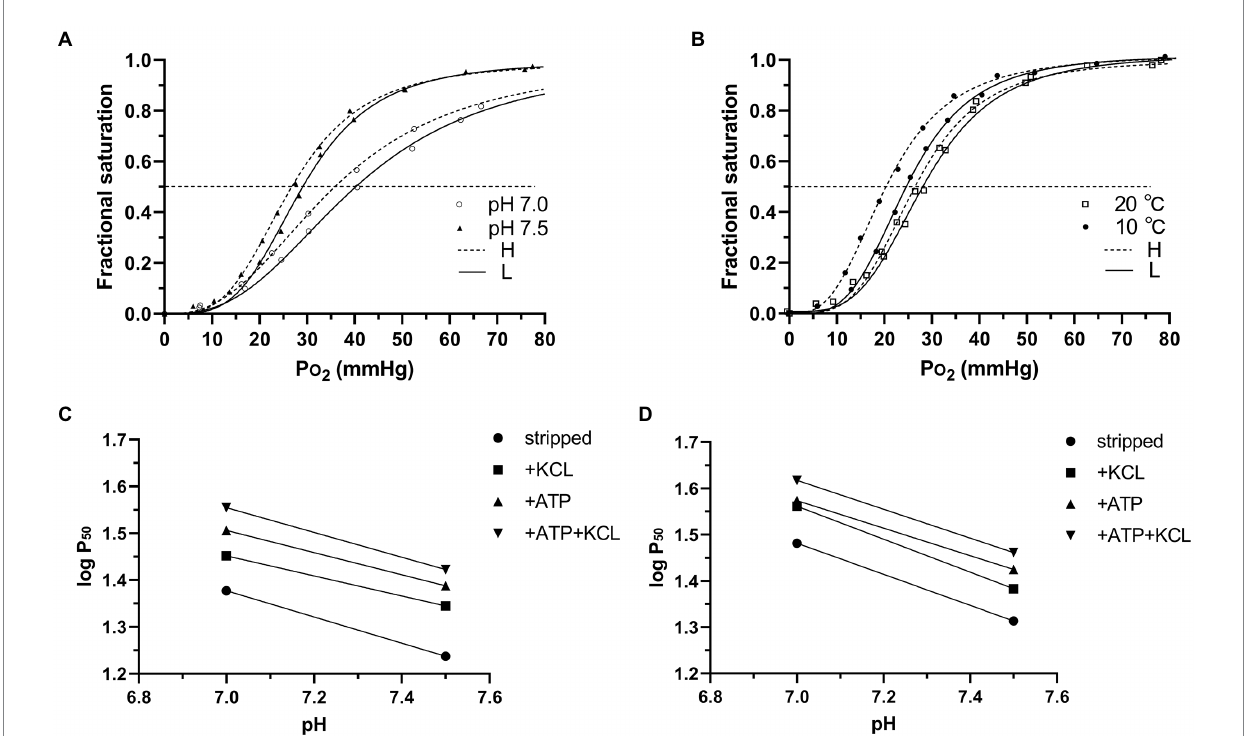
FIGURE 1 Representative O 2 equilibrium curves of high- and low-altitude black spotted frogs Hbs in pH7.0 and pH7.5 at 20 ° C (A) , and at 10 ° C and 20 ° C in pH 7.0 (B) in the presence of Cl − and ATP. Bohr plots [logP 50 vs. pH] of high-altitude (C) and low-altitude (D) black-spotted frogs Hbs in the absence (stripped) or/and presence of Cl − and ATP at 20 ° C. The slope of each of these linear plots is Bohr factor ( Φ ) reported in Table 4. The sample sizes of high- and low-altitude black spotted frogs are 6 and 12, respectively. Each experiment has been carried out six times.